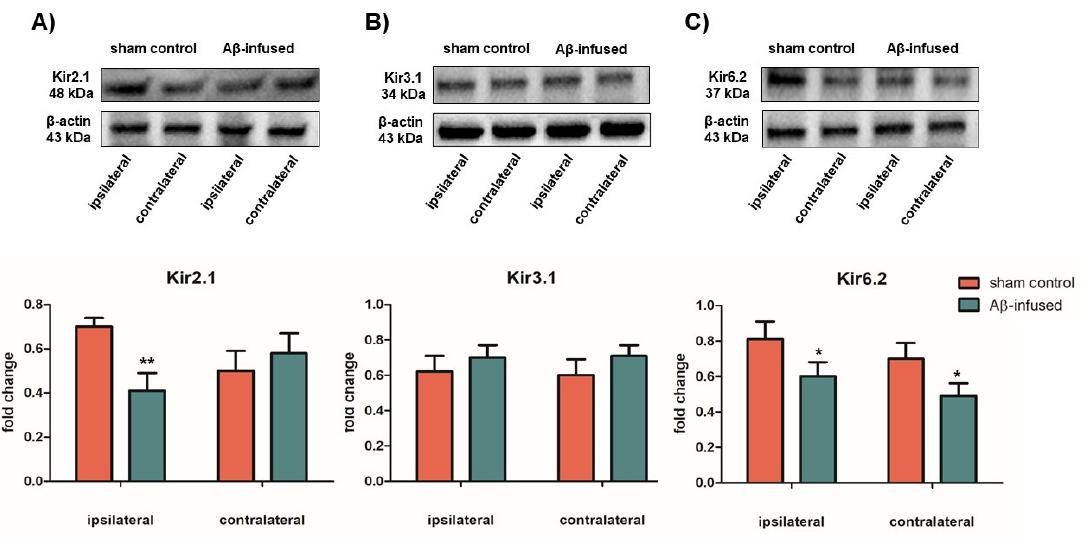
Figure 4. Protein expression levels of Kir2.1 ( A ), Kir3.1 ( B ), and Kir6.2 ( C ) channels in ipsilateral and contralateral hippocampi from both sham control and A β (1–42) -infused rat model. Upper panel: representative images of WB analysis on total protein extracts. β -actin was used as endogenous control for equal protein load. Lower panel: densitometric analysis of Kir2.1 ( A ), Kir3.1 ( B ), and Kir6.2 ( C ) protein levels. Data are expressed as fold change ratio on sham control and normalized to the β -actin protein levels. Bars represent the mean ± SEM obtained in 3 independent experiments, n = 7 for each group, * p < 0.05, ** p < 0.01.